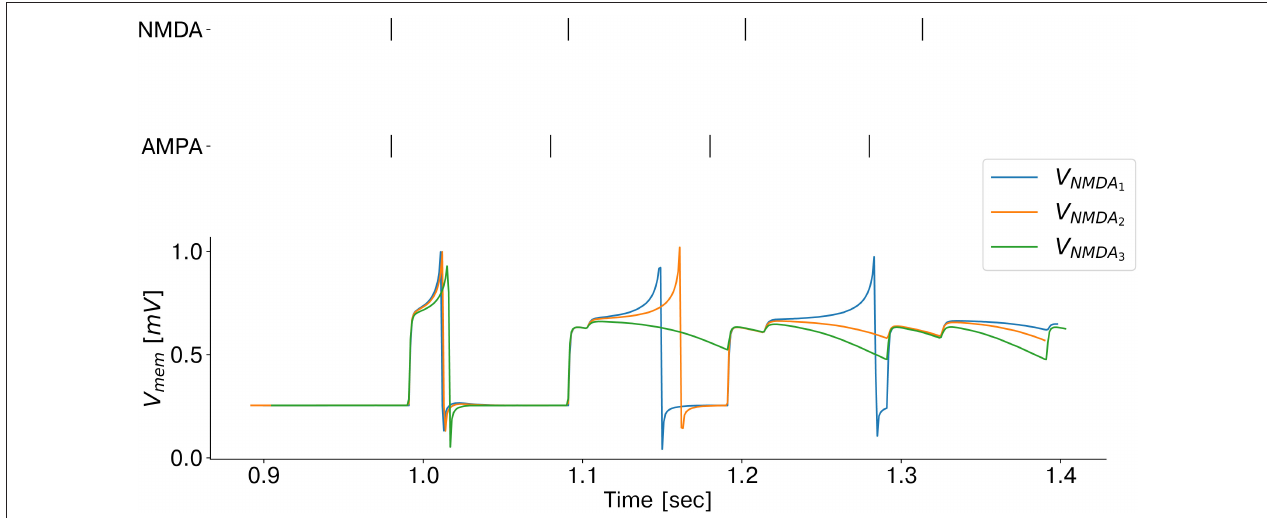
FIGURE 4 | Emulation of coincidence detection: recorded membrane potential of a coincidence detector as a function of the NMDA voltage-gating threshold ( V NMDA ). As the threshold decreases, the silicon neuron responds to larger inter stimulus interval delays and therefore, the coincidence detector sensitivity increases.